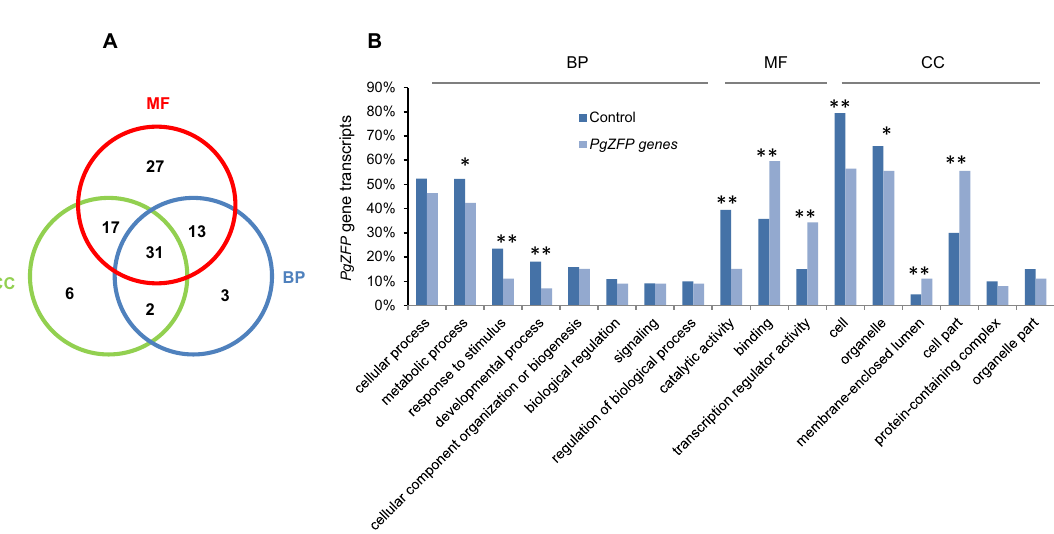
Figure 4. ( A ) GO categorization of the PgZFP gene transcripts. ( B ) Enrichment of the PgZFP gene transcripts. BP, Biological Process; MF, Molecular Function; CC, Cellular